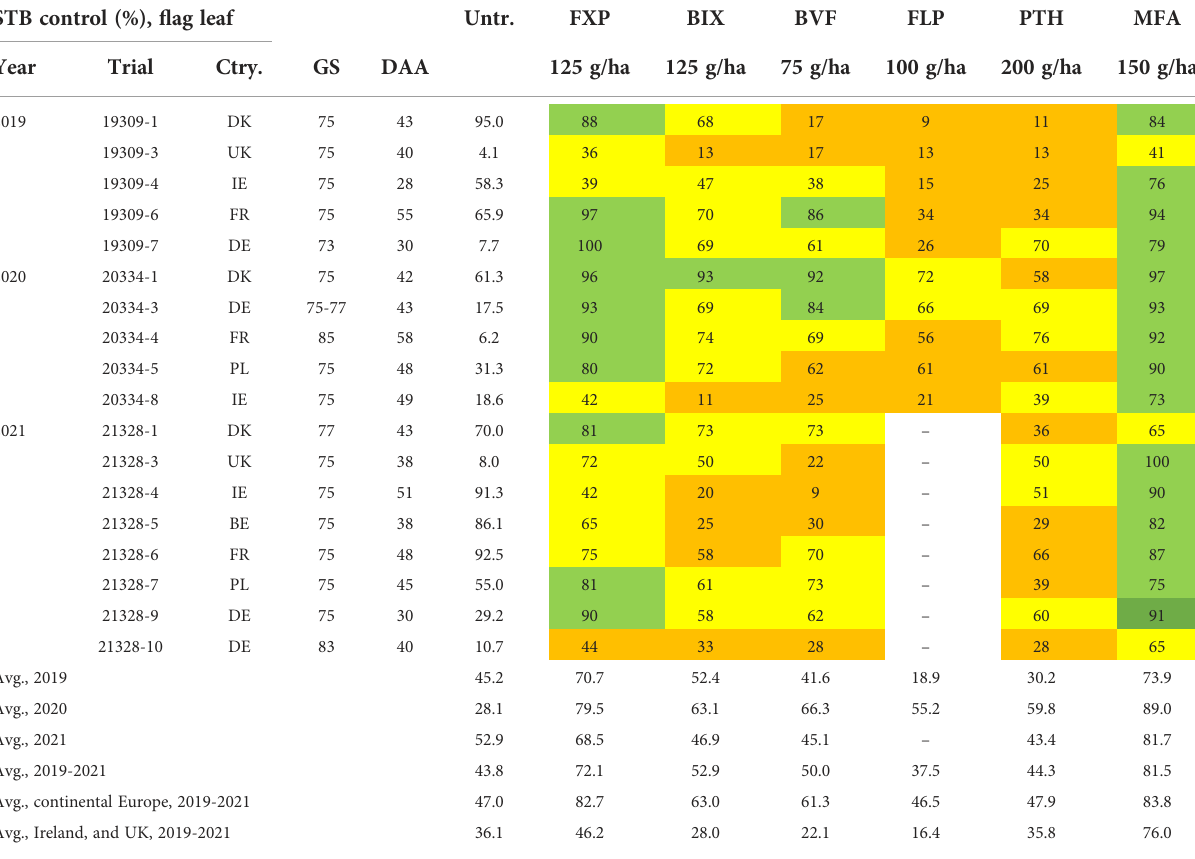
TABLE 3 Overview of septoria tritici blotch (STB) control and disease severity (%) in untreated (untr.) plots on fl ag leaves. STB control (%), fl ag leaf